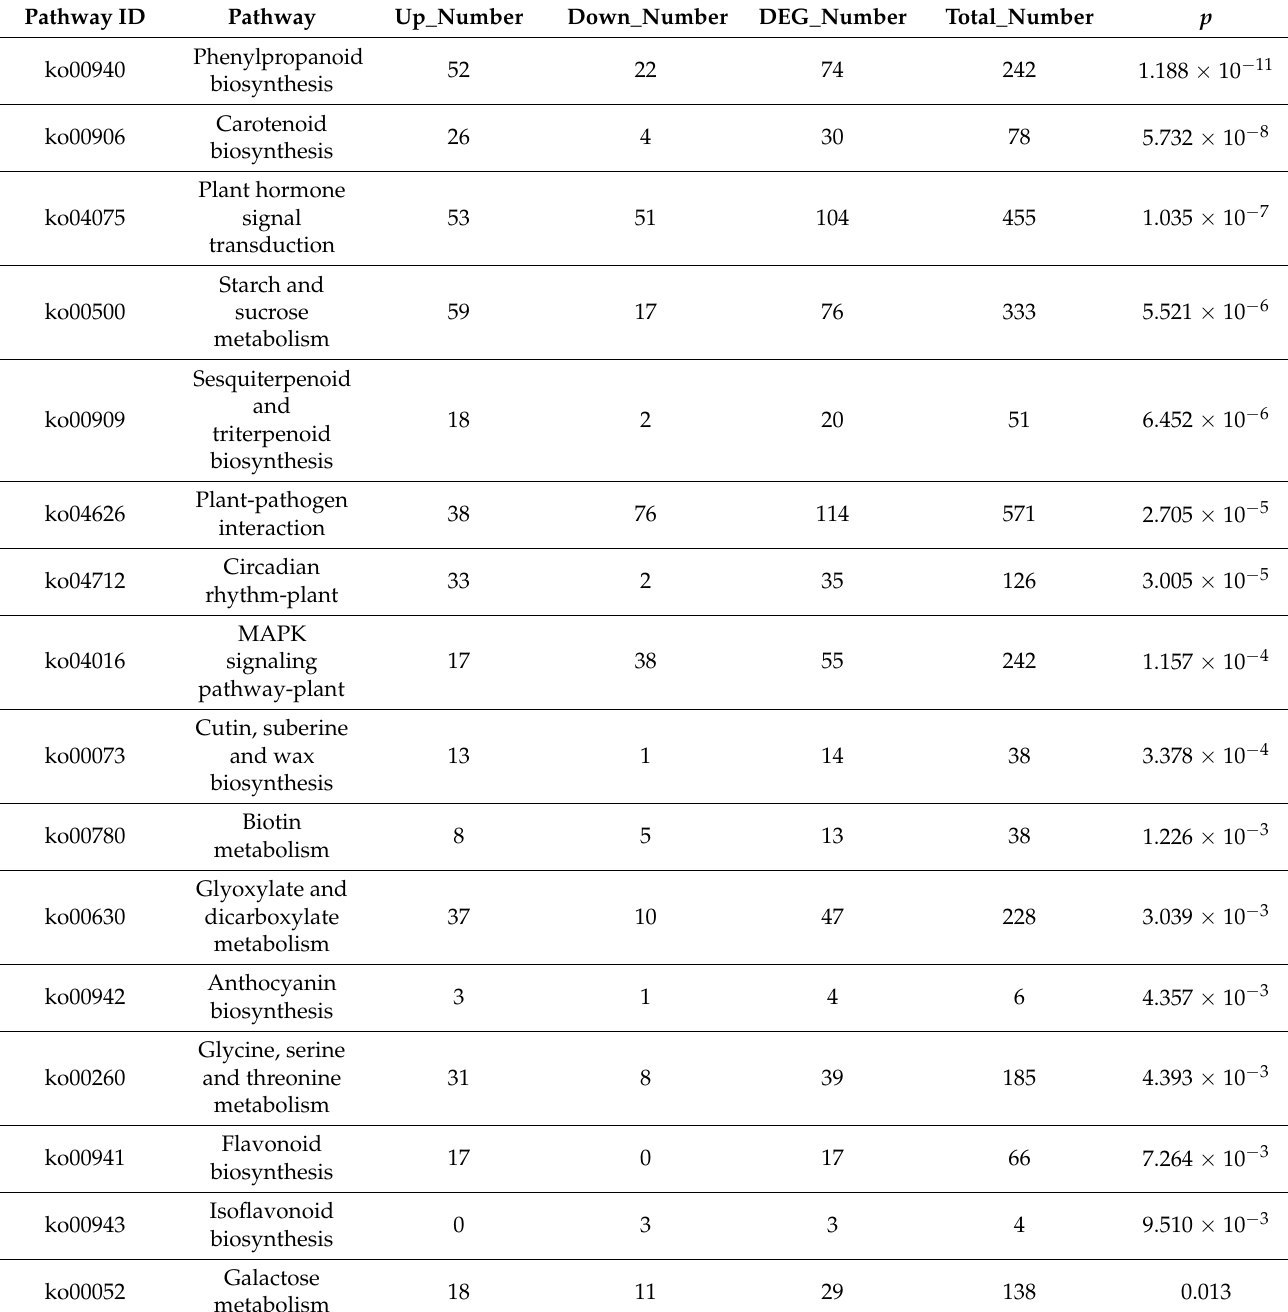
Table 3. KEGG enrichment analysis based on DEGs in the comparison of QLCK vs.